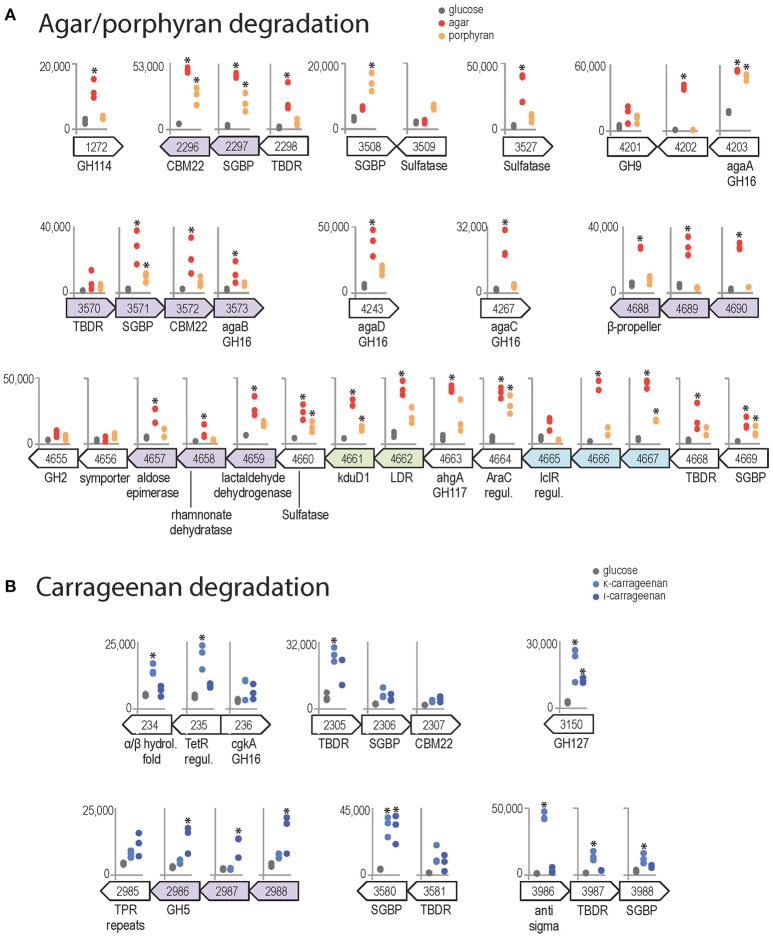
Genomic context and expression values of selected genes induced by red algal polysaccharides (FWER < 0.05). Asterisks denote significant up-regulation compared to glucose (FWER < 0.05). The y-axis scale reports normalized expression values and is conserved for each genomic region. Genes from the same genomic region and shaded with the same color were found to belong to the same transcription unit by the network approach. (A) Genes induced by agar (red) and/or porphyran (orange) compared to glucose condition (gray). (B) Genes induced by κ-carrageenan (light blue) and/or ι-carrageenan (dark blue) compared to glucose condition.